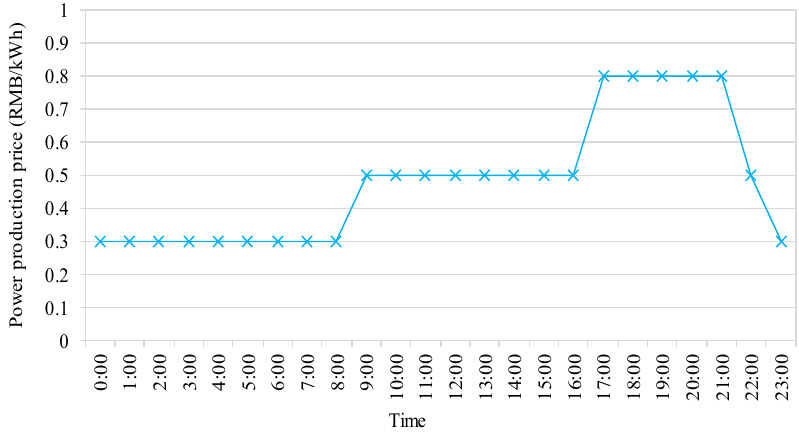
Figure A4. Price of power production.